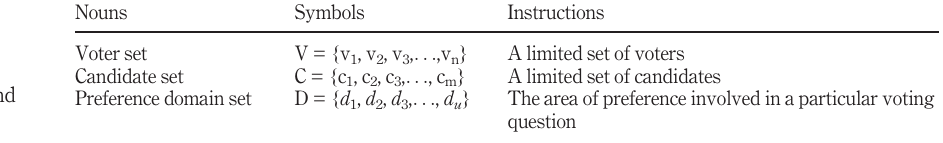
Figure 3. Representation in the